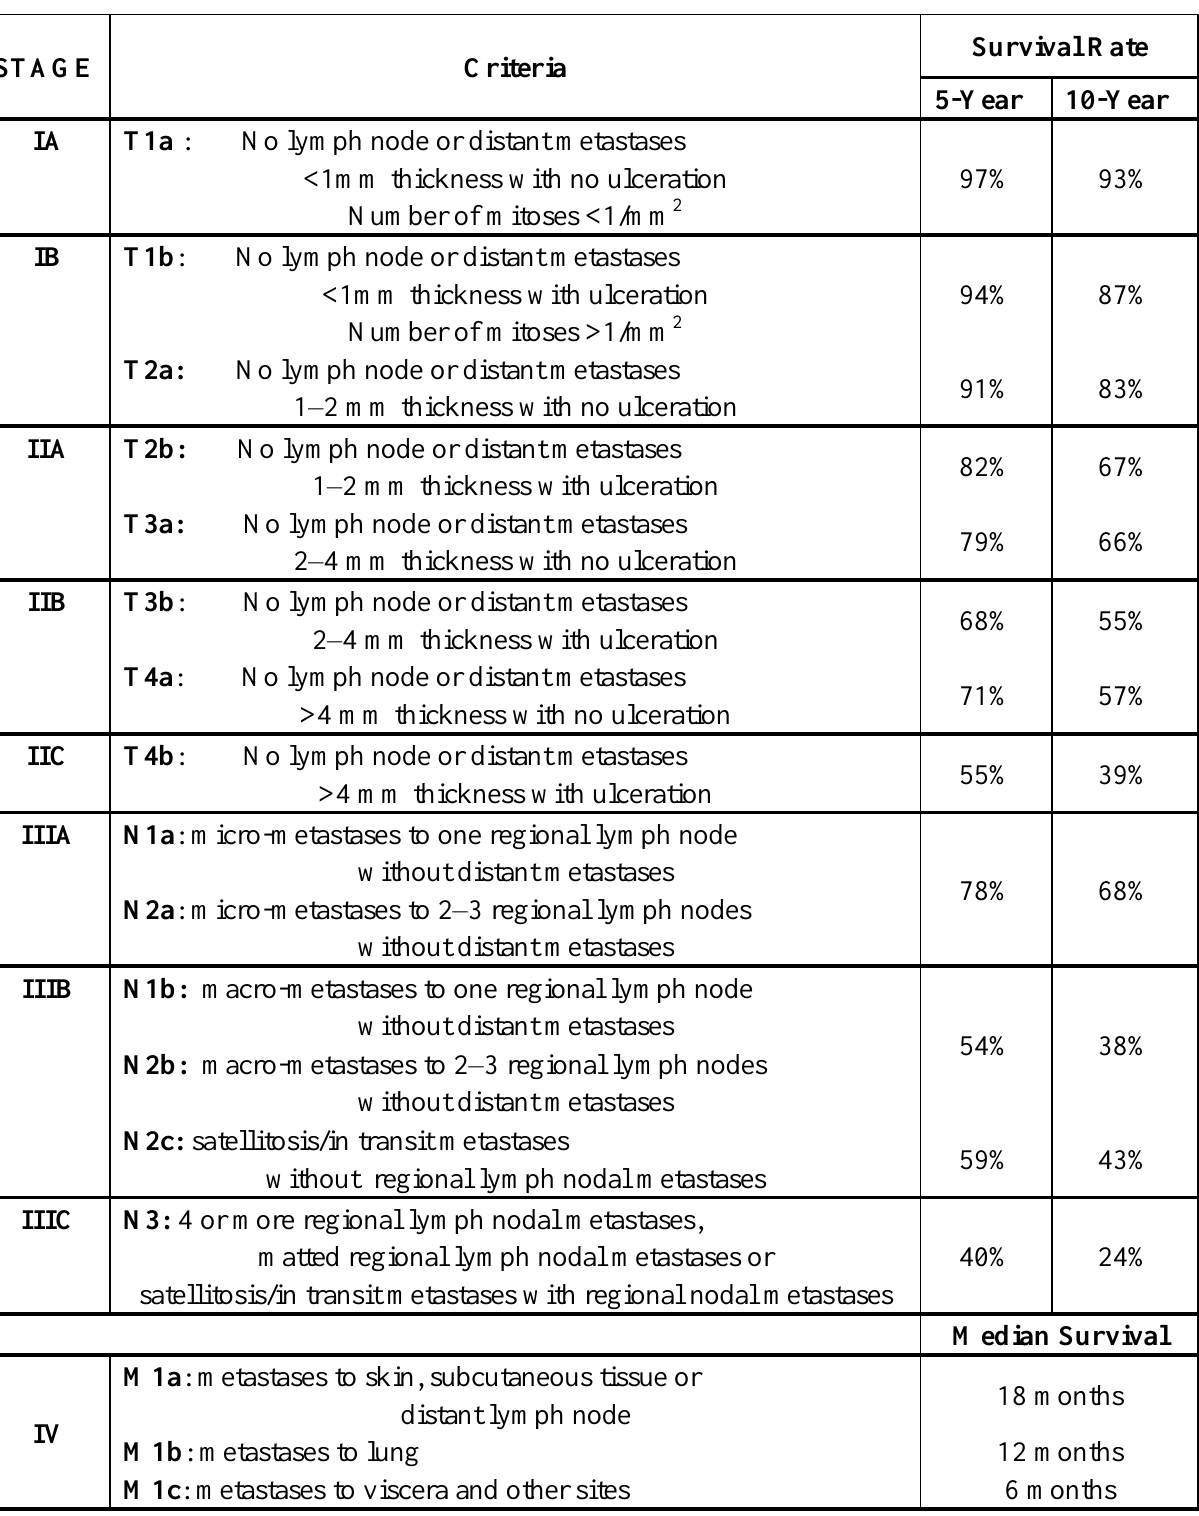
Table 1. AJCC staging system for melanoma